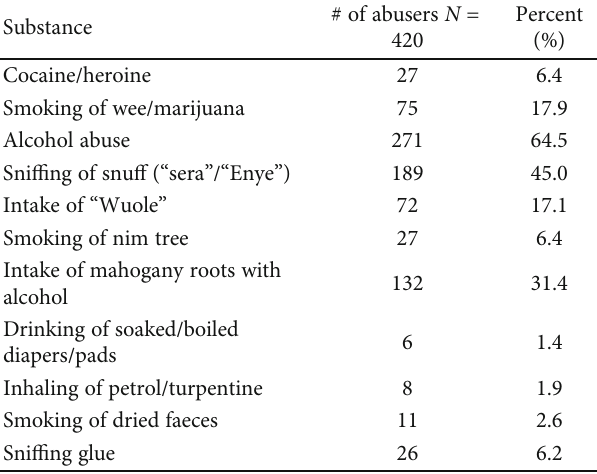
Table 5: Prevalence of other substance